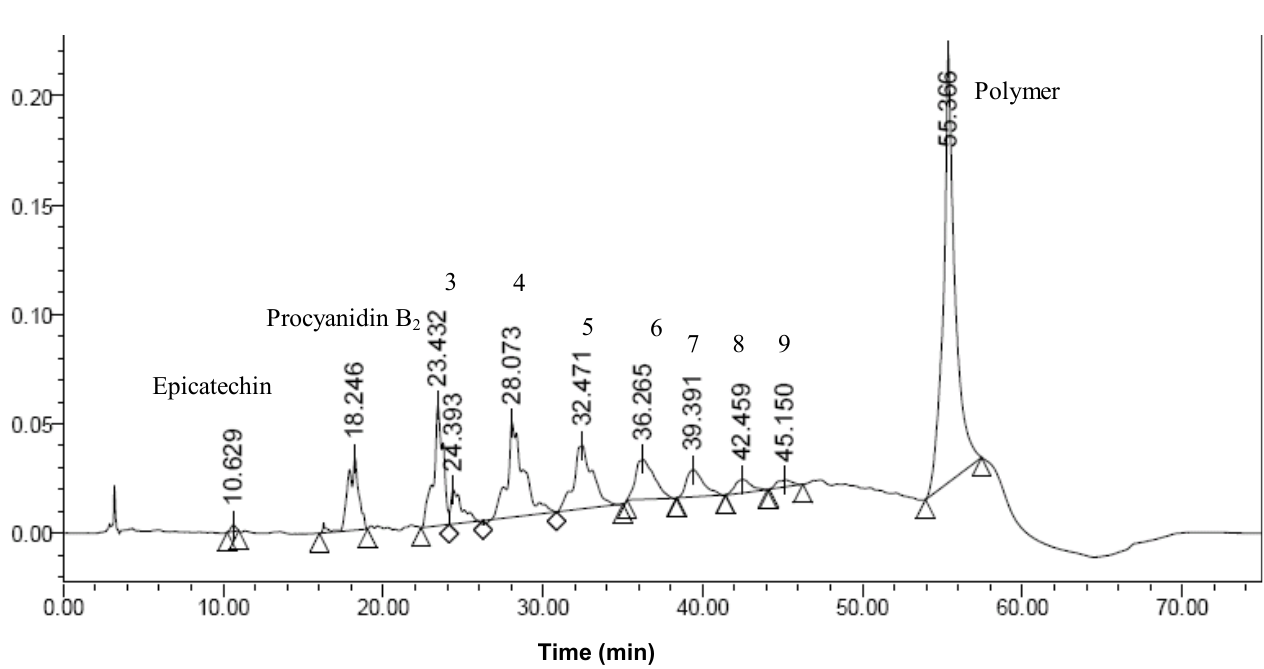
Figure 7. Normal phase HPLC separation of proanthocyanidins in durian seeds. The numbers above the peaks indicate the degree of polymerization of B-type